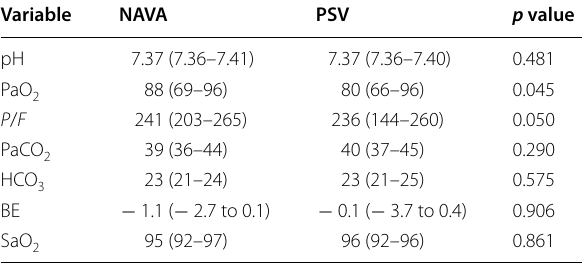
pH hydrogen potential, PaO 2 arterial oxygen pressure, P/F ratio of arterial oxygen pressure divided by the fraction of inspired oxygen, PaCO 2 arterial pressure of carbon dioxide, HCO 3 bicarbonate, BE base excess, SaO 2 oxygen saturation Data presented as median and 25–75% interquartile range. p value obtained by Wilcoxon signed‑rank